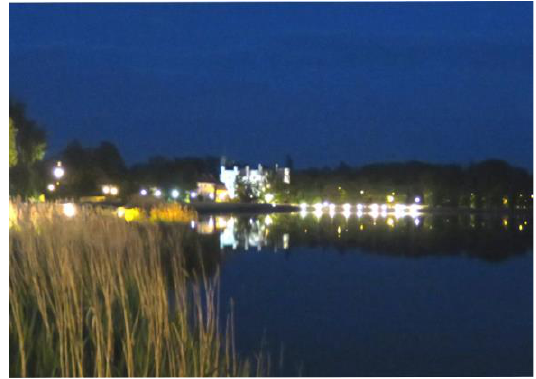
Fig. 2. Illumination of the Kórnik Castle visible from the shoreline of the lake [1] The illumination of the Kórnik Castle combined with water is a unique showpiece of the small town of Greater Poland [1]. The average luminance of light